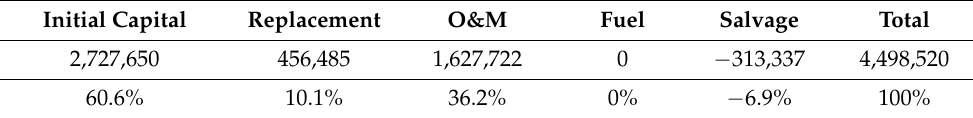
Table 10. Lifetime cost structure of topology_B by source (unit: USD).